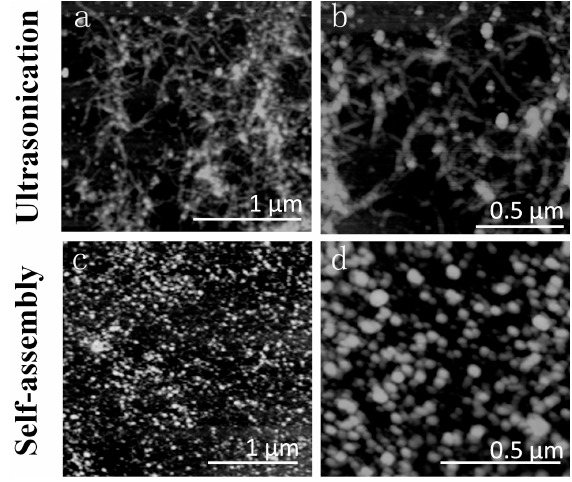
Figure 3. AFM images of SKS50 ( a , b ) and SKN50 ( c , d ) samples with the same silk composition (diluted to 0.01 wt % ). Both samples are shown at two scale bars: 1 and 0.5 μ m.